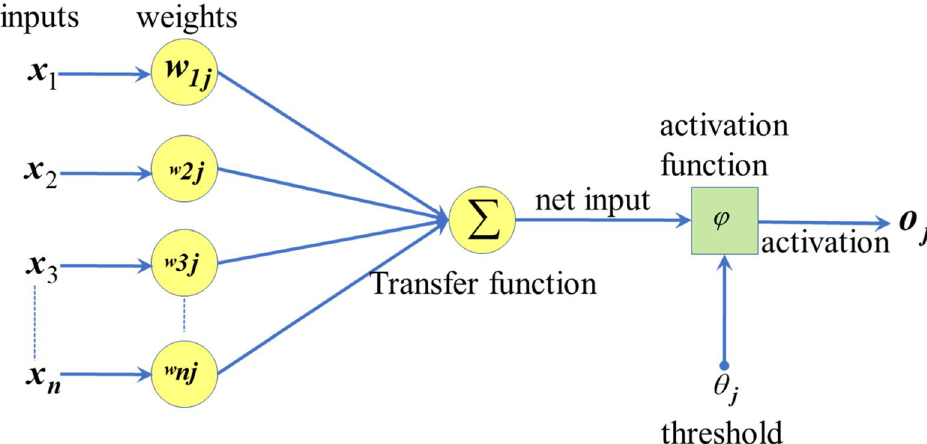
Figure 2. Structure of the proposed model .